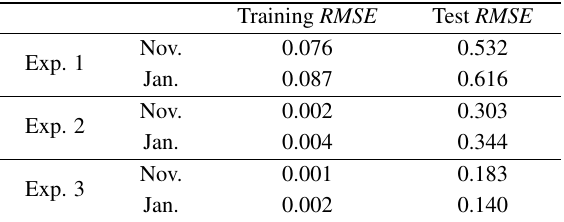
Table 19 Prediction evaluation using counts of reporting tweets and hospital visits.